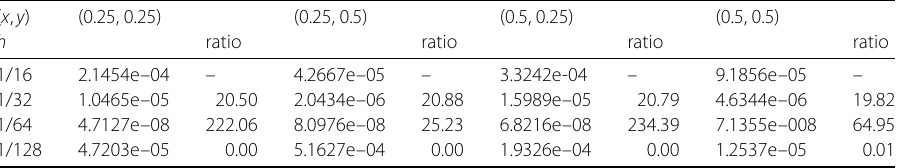
Table 8 The errors for the RBF collocation method in the sense of